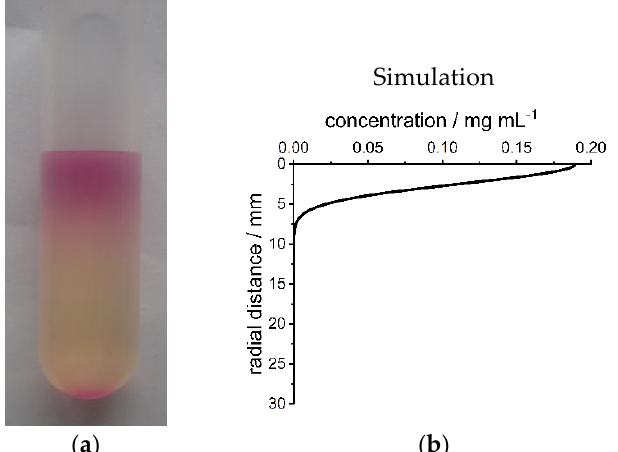
Figure 9. ( a ) Photograph of gelatin nanoparticle gradient material with a gradient of RITC-SiNPs obtained after centrifugation in a preparative ultracentrifuge at 3000 rpm (1094 RCF(max)) and 40 °C for 20 h. The size of the material is 3 cm length and 1 cm diameter; ( b ) simulated concentration gradient of the material from ( a ). The scales of ( a ) and ( b ) are identical. Radial distance is distance from the top of the material.